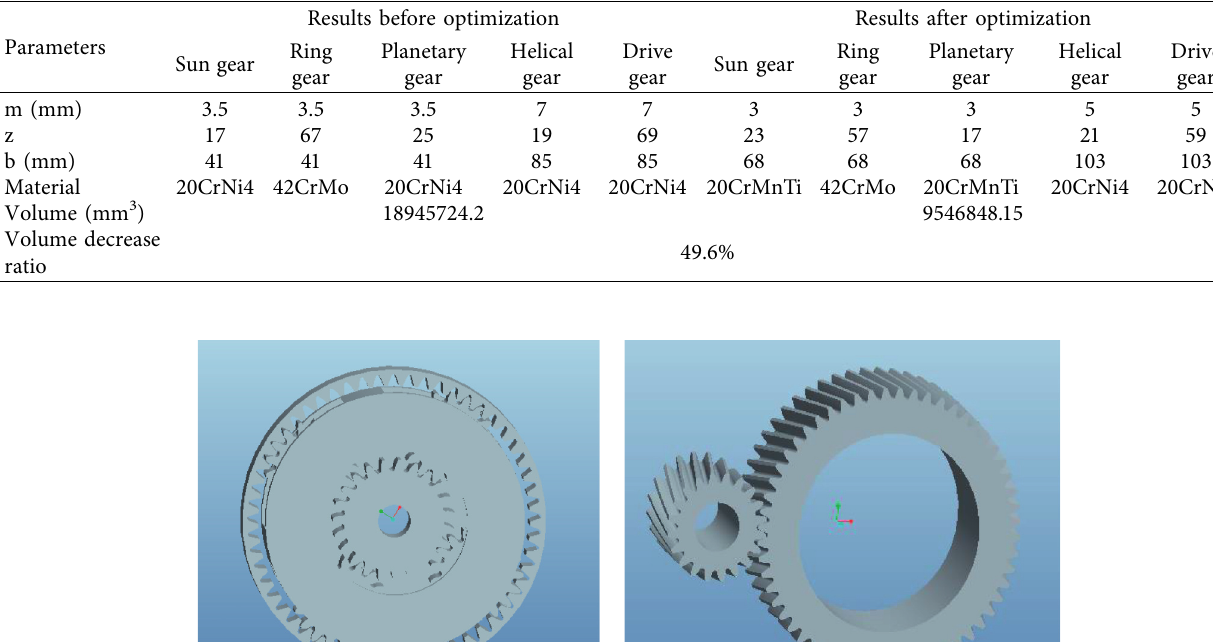
Table 2: Comparison of reducer parameters before and after optimization.